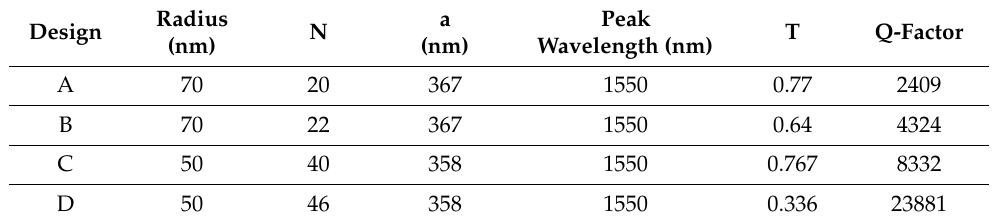
Table 1. The simulation results of the 1D PhC and the corresponding quality factor (Q-factor)